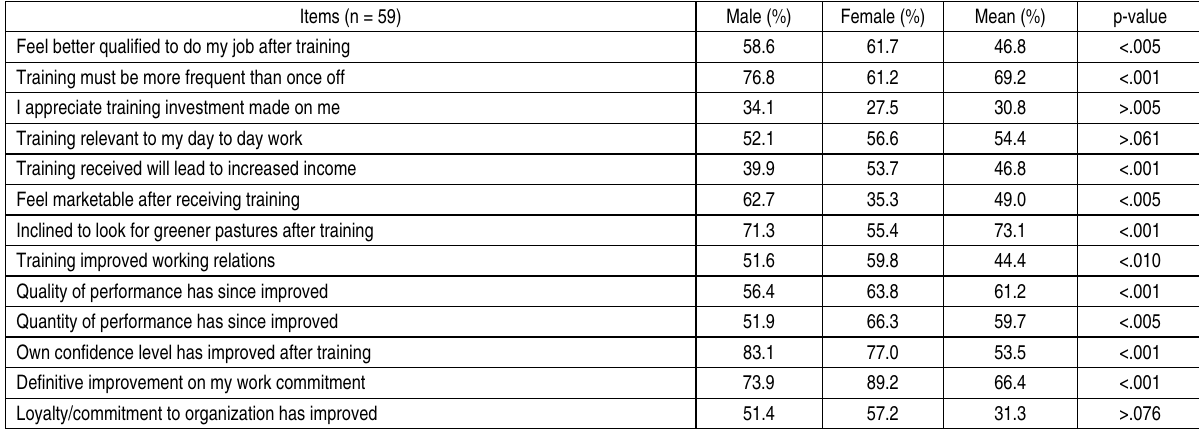
Table 5. T-test results for